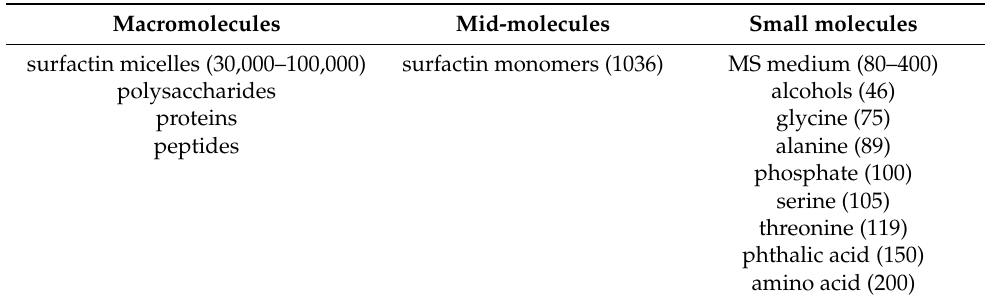
Table 1. Components and their molecular weights (the numeral in the parentheses, in g/mol) in the raw B. subtilis ATCC 21332 fermentation broth